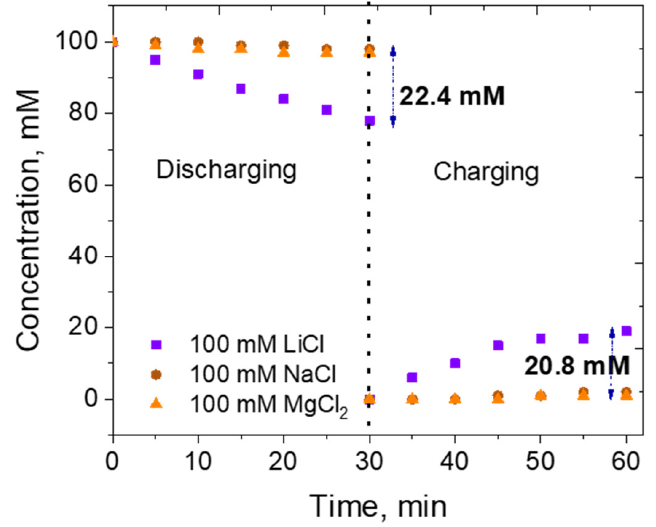
Figure 4. Concentration of the targeted ion in the source solution during the discharging phase, performed at a current density of −0.5 mA cm −2 for 30 min, and the concentration of the same ions in 50 mM KCl recovery solution during the charge phase at a current density of 0.5 mA cm −2 for 30 min.